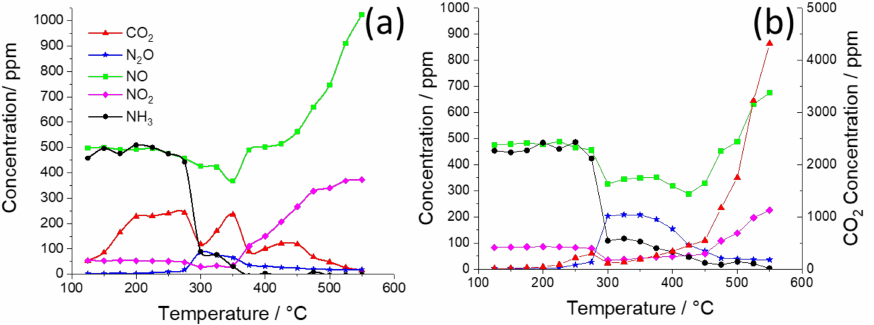
Figure 9. Performance of 2%Ag–5%K/CZA tested in a simulated exhaust gas containing NH 3 as reductant ( a ) in the absence of carbon black, and ( b ) in the presence of carbon black. Both in the absence and presence of carbon black, 2%Ag–2%K/CZA (Figure 10) functioned as a NOx-reduction catalyst below 300 ◦ C, before NH 3 oxidation predominated at higher temperatures. The onset temperature for NO and NH 3 conversion (200 ◦ C) closely matched that of K-free Ag/CZA, as did the amount of NO converted, indicating that the potassium was having a negligible effect on the active sites located on the Ag and the CZA. From BET data (see Supplementary Materials), it was calculated that 6.02 × 10 − 8 mol g − 1 of K ions would be required for monolayer coverage of the CZA support, which is much less than the theoretical concentration (4.99 × 10 − 4 mol g − 1 ) of K in 2%Ag–2%K/CZA. Therefore, the catalytic performance suggests that much of the K 2 CO 3 was incorporated into the catalyst bulk and/or was present as discrete crystallites on the catalyst surface.